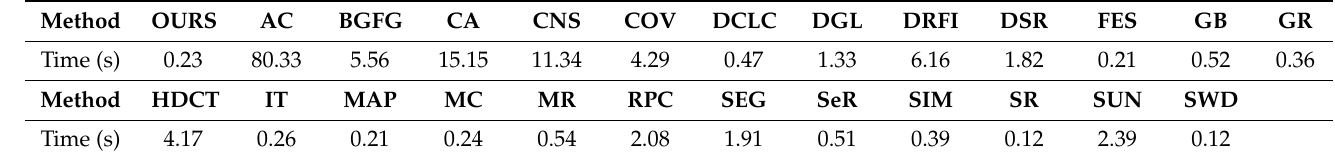
Table 6. Average running time of 25 methods on ECSSD